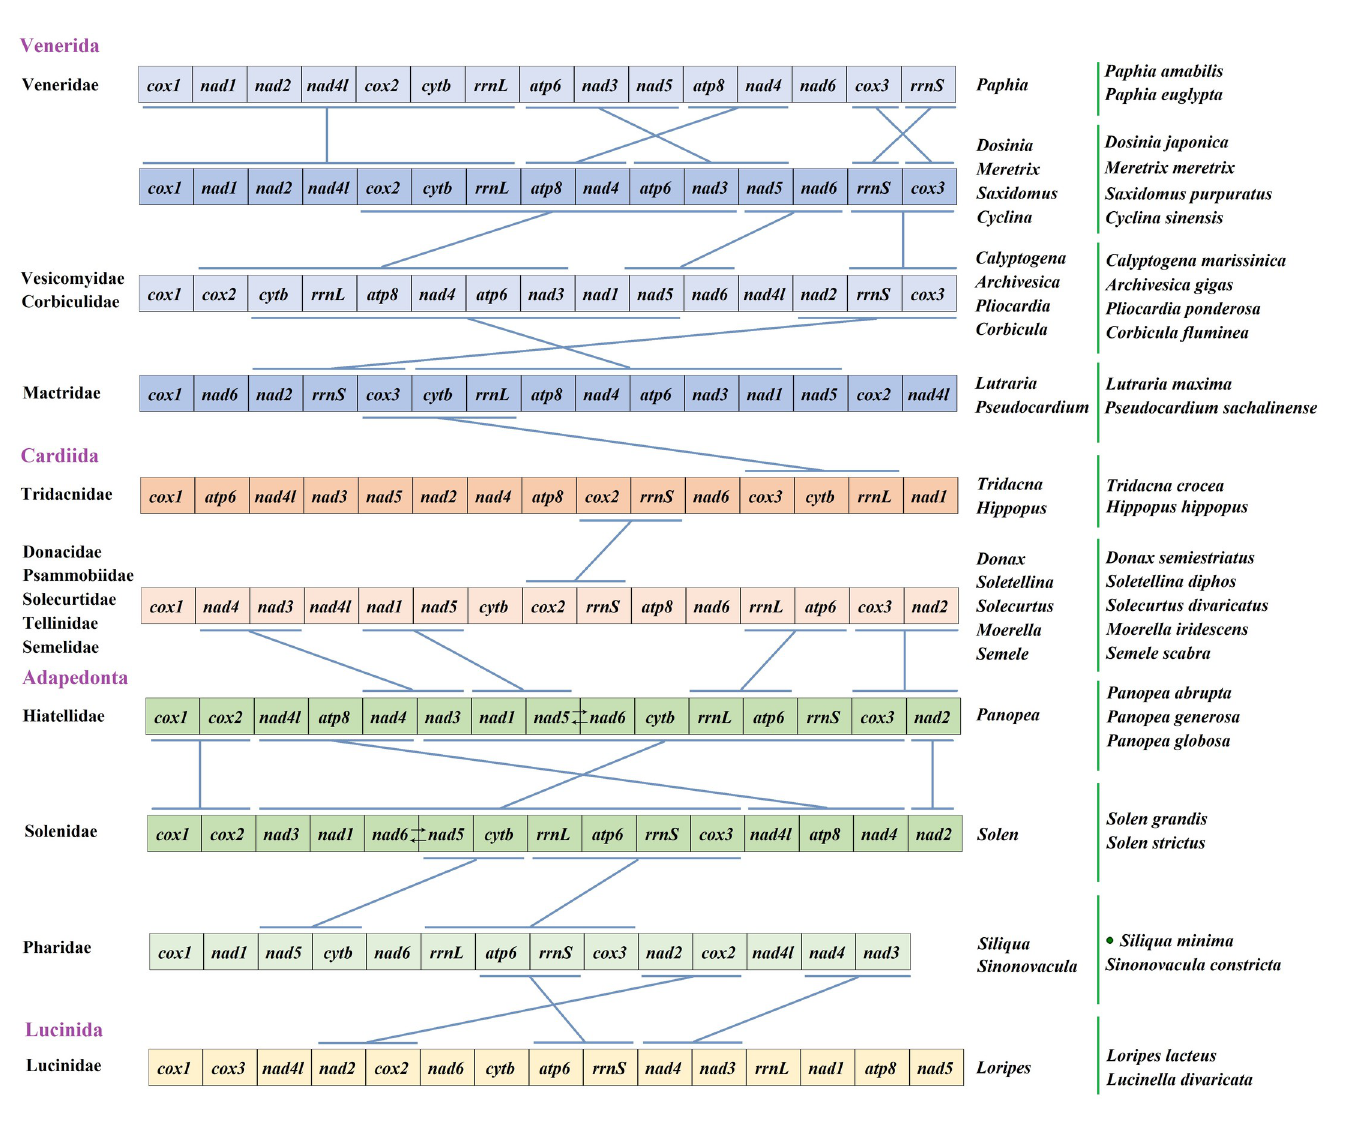
Fig 6. Linearized representation of the mitochondrial gene arrangement in Impardentia bivalves. The bars indicate identical gene blocks. Gene segments are not drawn to scale. The green dot indicates the specie of this study. same as nad3-nad1-nad6-nad5-cytb-rrnl-atp6-rrns-cox3 gene arrangement in the family Sole- nidae, only nad5 and nad6 genes in the reverse order. They are the two families with the closest gene arrangement in this study. The sequence of nad5-cytb and rrnL-atp6-rrns-cox3 was the same as that of the family Pharidae. Moreover, species of Pharidae lack atp8 gene, which is also common in bivalve species. Compared with the species of the family Lucinidae, there are only three identical gene blocks: atp6-rrnS , nad2-cox2 , nad4-nad3 . Through above analysis we can find that although the gene sequence among bivalve species is highly variable, the same gene arrangement is longer among the species with closer genetic relationship. However, the possi- bility of rearrangement of the contrast between the spanning orders is greater. It shows that